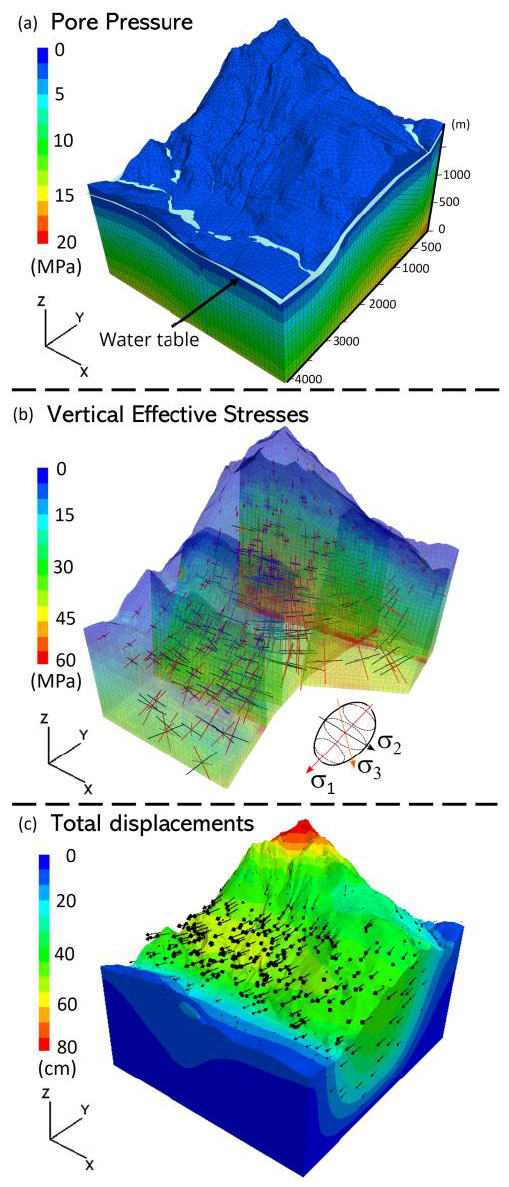
Figure 5. Pore pressures ( a ), effective stresses ( b ), and total displacements ( c ) simulated along the modelled slope at initialization phase.